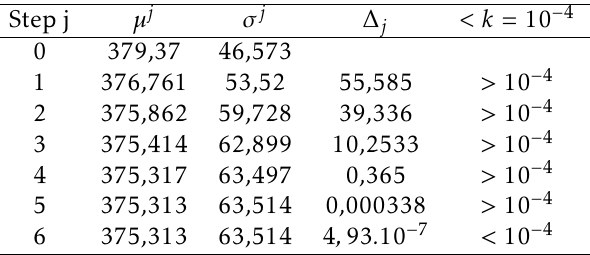
Table 2. Maximum water lever in Tien river, An Giang province